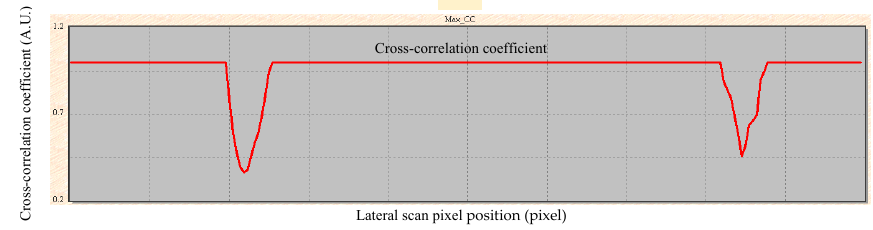
Figure 3. Cross-correlation coefficient curve along the lateral scan axis on a rectangular gauge block with two surface edges.